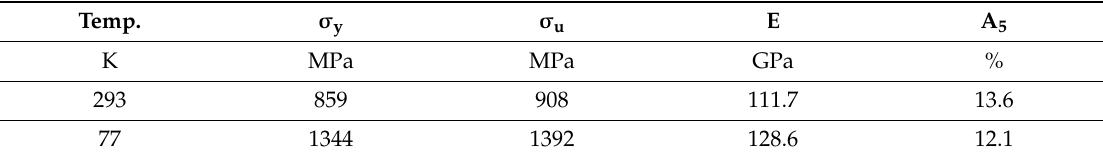
Table 4. Mean values of the mechanical properties of Ti6Al4V titanium alloy at ambient and cryogenic condition [37].